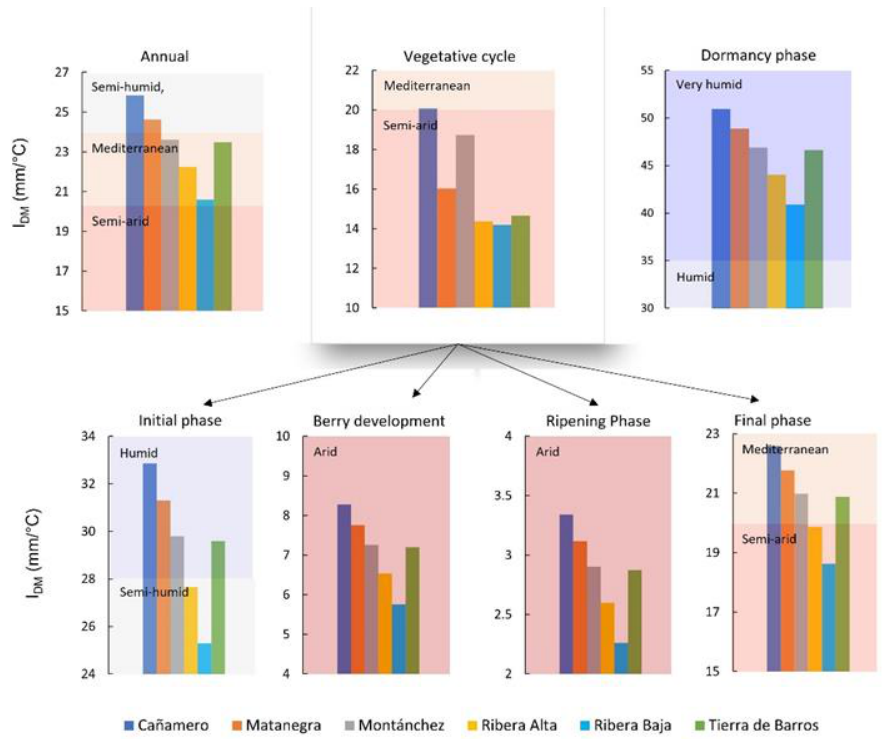
Figure 6. I DM for the subzones of the Ribera del Guadiana Protected Denomination of Origin, for the vine phases (1989 – 2020).